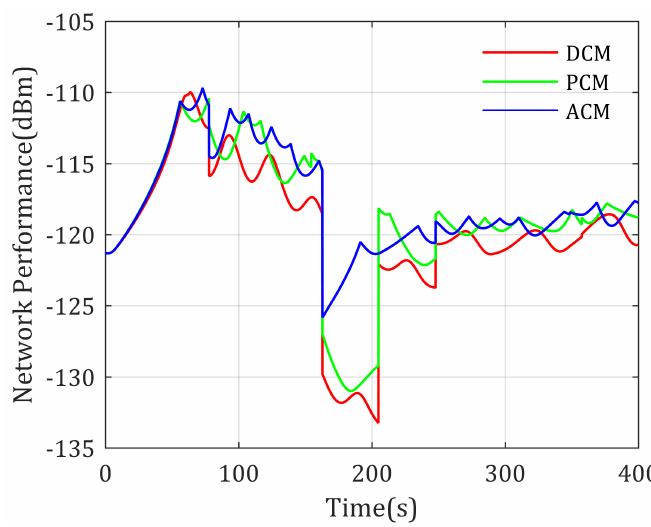
Figure 11. Network performance for two mobile agents end-to-end communication with known channel parameters.